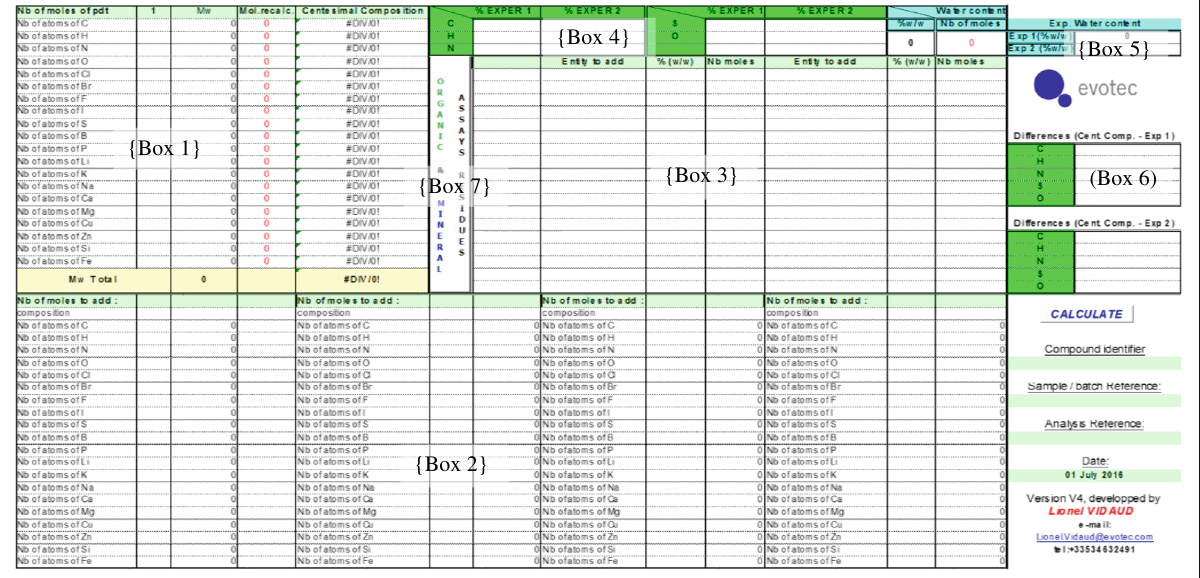
Fig. 1 Screenshot of user interface of the MAT-CHN – { Box 5} : is the specific place of the water content determination, two experimental results are recordable. On the left, the average content calculation is provided. – { Box 6} : corresponds to the comparisons of the experimental and the recalculated elemental compositions, when the “ CALCULATE ” button is activated. A color coding is established to highlight results with acceptable criteria ( ≤ ± 0.3%) in green, critical results in yellow (between ±0.3% and ± 0.4%) and out of criteria ( ≥ ± 0.4%) in red. – { Box 7} : corresponds to the button “ Organics and mineral assays residues, ” opening the personal library of the users containing pre-defined sub- stances, or ions which, when selected, will appear in the list of the {Box 3}. The user can add or sup- press these defined compounds. The added sub- stances are recorded, of course, with their respective raw formulae and charges. This function- ality is needed to use Mat-CHN, but is not de- scribed here, because not directly belonging to the calculation principles. Atomic elements proposed in this table are the most fre-